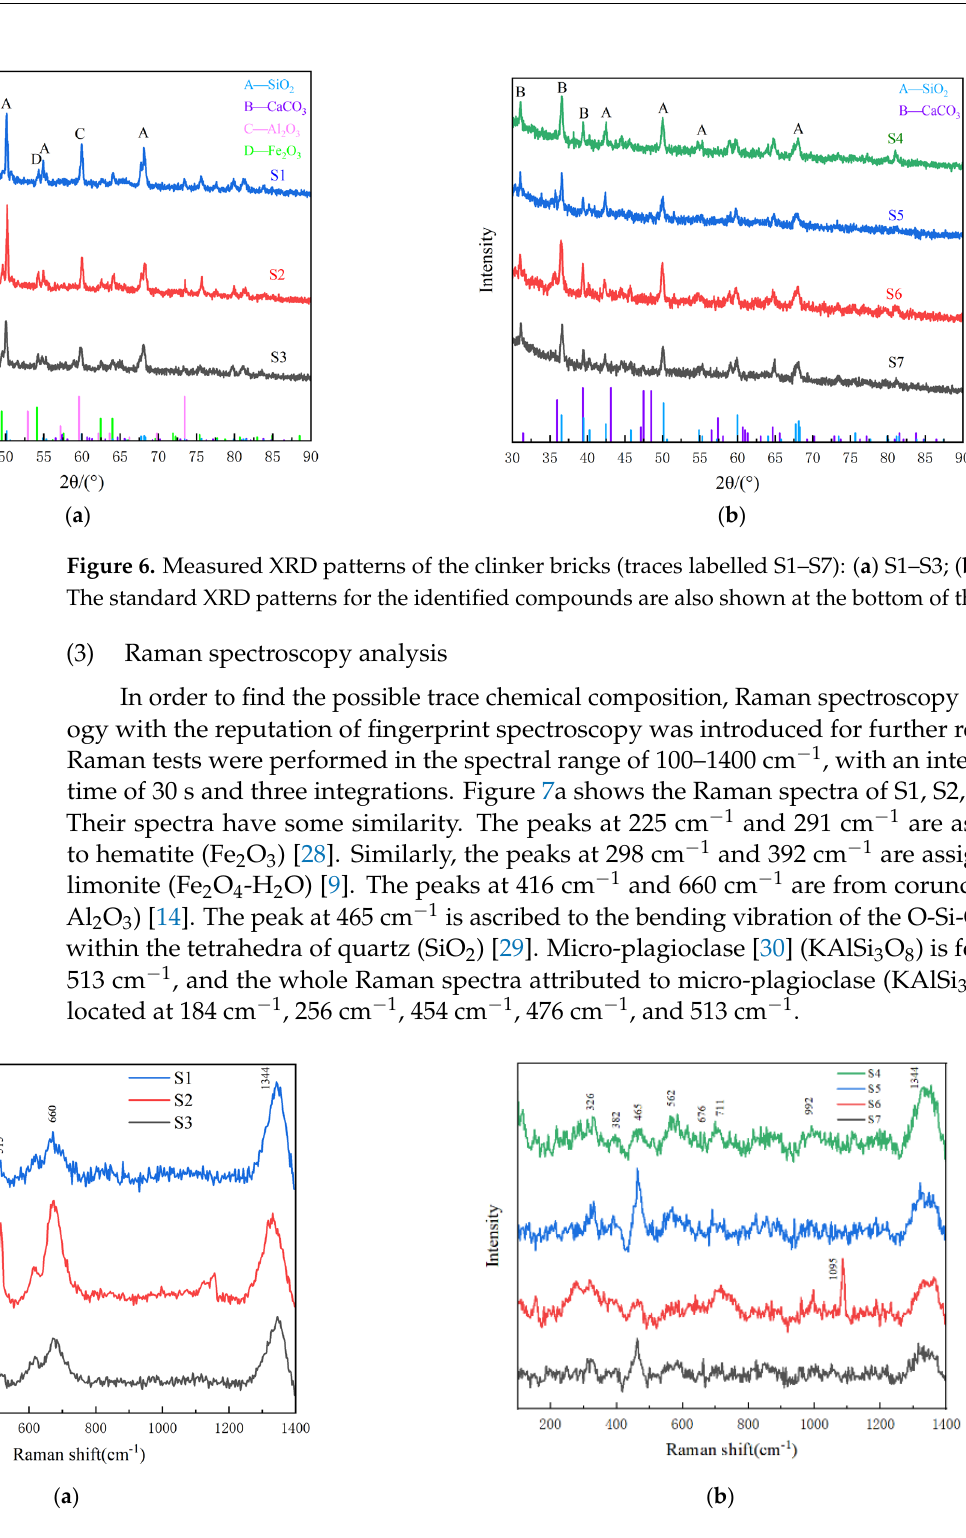
Figure 8. Water absorption coefficient of 7 samples. Table 3. Water absorption capacity (WAC, weight per weight [wt./wt.]), imbibition capacity (IC, [wt./wt.]), and open porosity (vol./vol.) of samples. Sample WAC [%, wt./wt.] IC [wt./wt.]